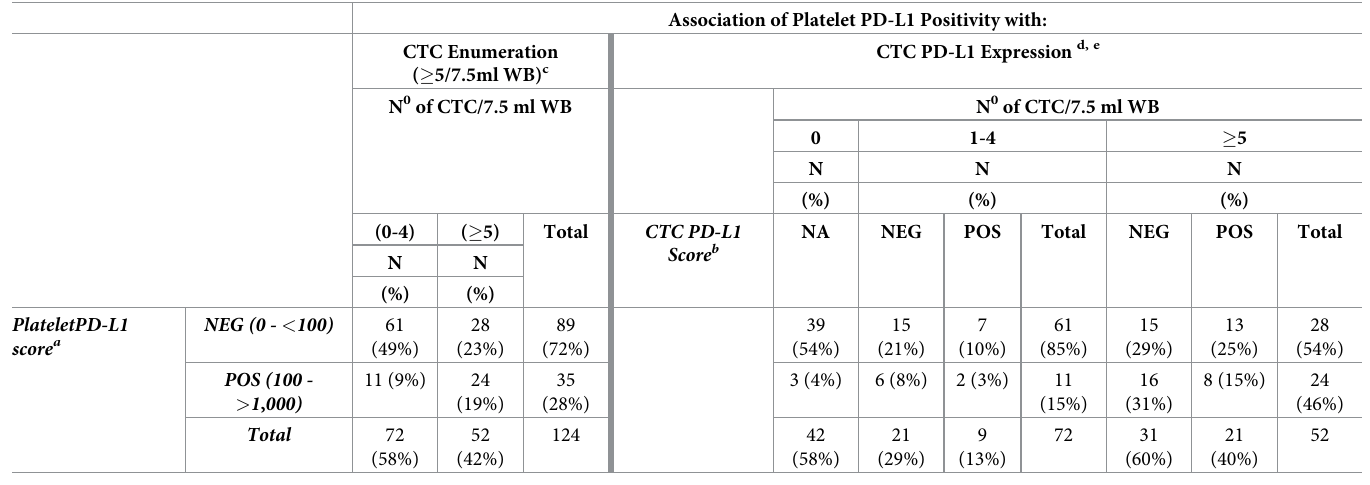
Table 3. Association of platelet PD-L1 score and CTC enumeration and PD-L1 expression at timepoint-1.